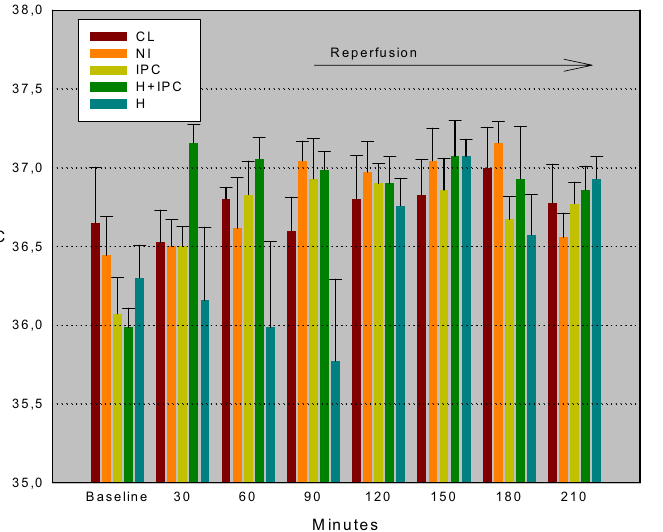
FIGURE 2 - Temperature means of each evaluation in all groups. Ischemia: 30-90 minutes. Reperfusion: 120-210 minutes. No significant differences between the groups